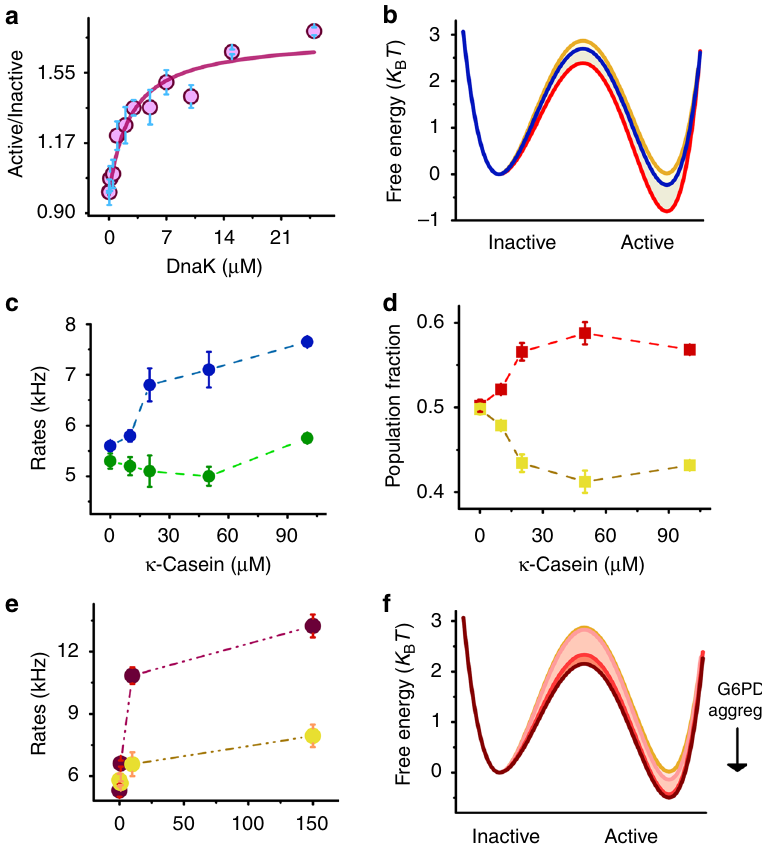
Fig. 4 DnaK and substrate binding stabilize the active state of the M domain. a Population ratio of state 1 and state 2 (active/inactive) shows a monotonic increase (purple circles). The solid line is a fi t to a binding model, yielding a K d of 3 ± 1 µ M. b Free-energy pro fi les of the M domain calculated from H 2 MM- derived populations and rates obtained from the analysis of smFRET data at three concentrations of DnaK: 0 µ M (orange), 5 µ M (blue) and 25 µ M (red). Both rates increase with DnaK, but k 21 increases more, leading to the accumulation of the active state. For the values of the rates see Supplementary Table 7. c ClpB was incubated with increasing concentrations of κ -casein. Measurements showed the rate k 21 is increasing as a function of κ -casein (blue color), while the rate k 12 is decreasing (green color) (Supplementary Table 8). d The active (red) and inactive (yellow) state populations as a function of κ -casein concentration are shown, demonstrating an anti-correlated trend. e ClpB was incubated with increasing concentrations of G6PDH aggregates (treated with 10 µ M DnaK and 1 µ M DnaJ). smFRET measurements and H 2 MM analysis showed that k 21 dramatically increased with increasing G6PDH aggregate concentration (purple color), while k 12 increased only slightly (yellow) (Supplementary Table 9). The dashed lines in C-E are intended to guide the eye only. f Free-energy pro fi les calculated from the rates and the model as obtained from a smFRET measurement and H 2 MM analysis of ClpB in the presence of G6PDH aggregates. By increasing the G6PDH aggregate concentration (light red to dark red color) state 1 is stabilized and the free-energy barrier between state 1 and 2 is reduced (for the ratio between the states see Supplementary Table 10), affecting mostly the transition from state 2 to state 1. Error bars represent standard errors of the mean. Source data are provided as a Source Data fi